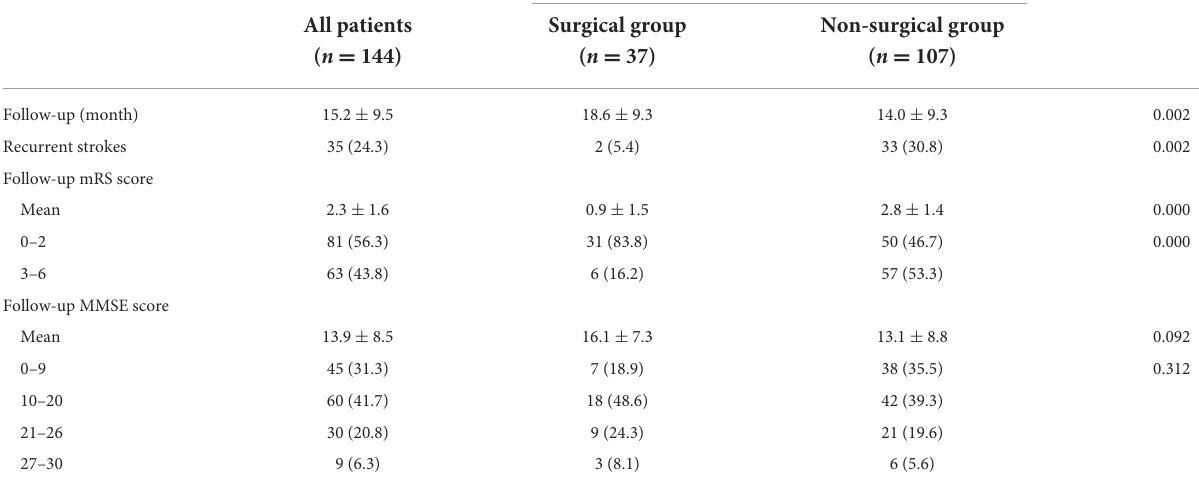
TABLE 3 Neurological status and cognitive function during follow-up in surgical and non-surgical group. Treatment Modalities P